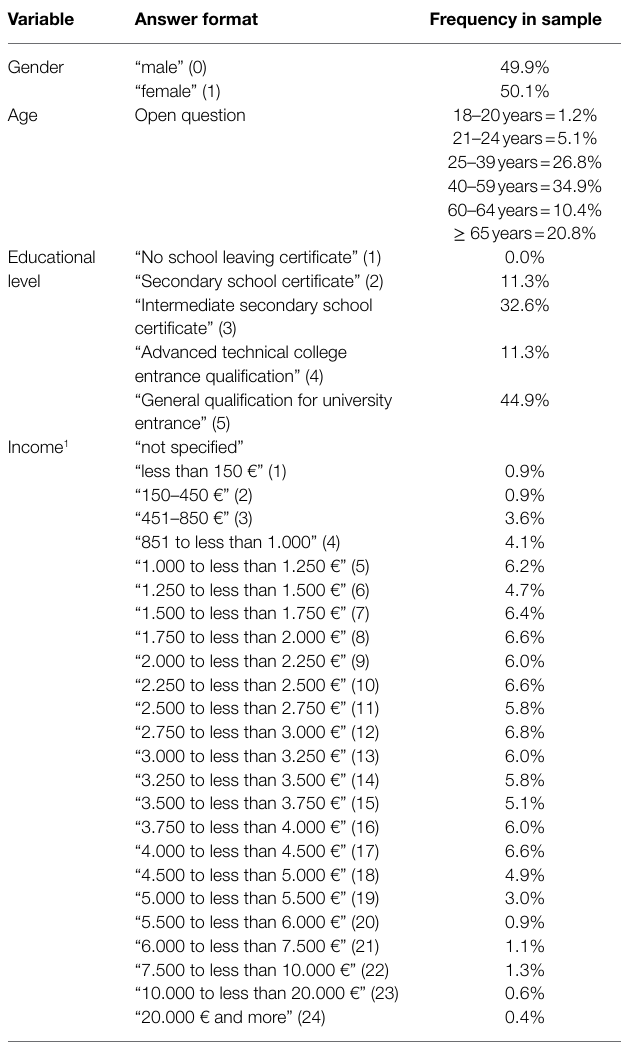
TABLE 1 | Frequency statistics of the sociodemographic variables of the participants ( N =